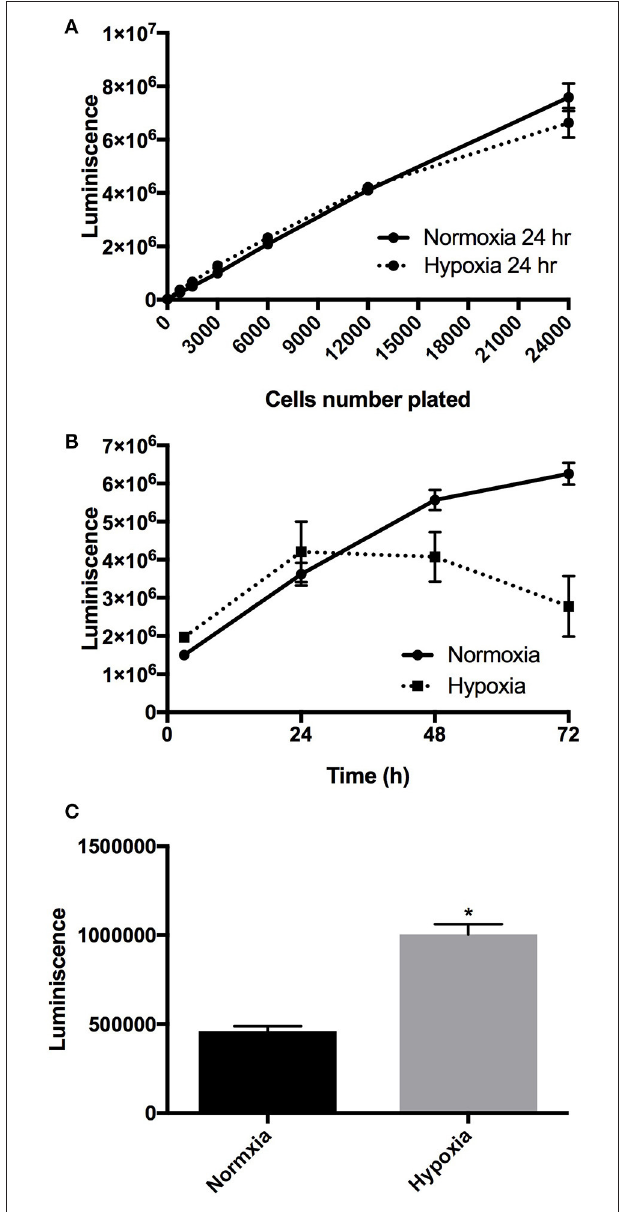
FIGURE 1 | (A) Demonstrates the luminescence detected by real-time cell viability assay with a different number of cells/well with 24 h of normoxia and hypoxia exposure. (B) Demonstrates the changes in luminescence during 1 to 3 days of hypoxia exposure indicating the changes in cell viability and proliferation. N = 6 in each group. Data is presented as mean and standard error of mean. (C) Demonstrates a significant increase ( P < 0.05; n = 6) in Caspase 3/7 activity in hypoxic cells as compared to that from normoxic cell. N = 6 in each group; *Denotes P < 0.05. Data is presented as mean and standard error of